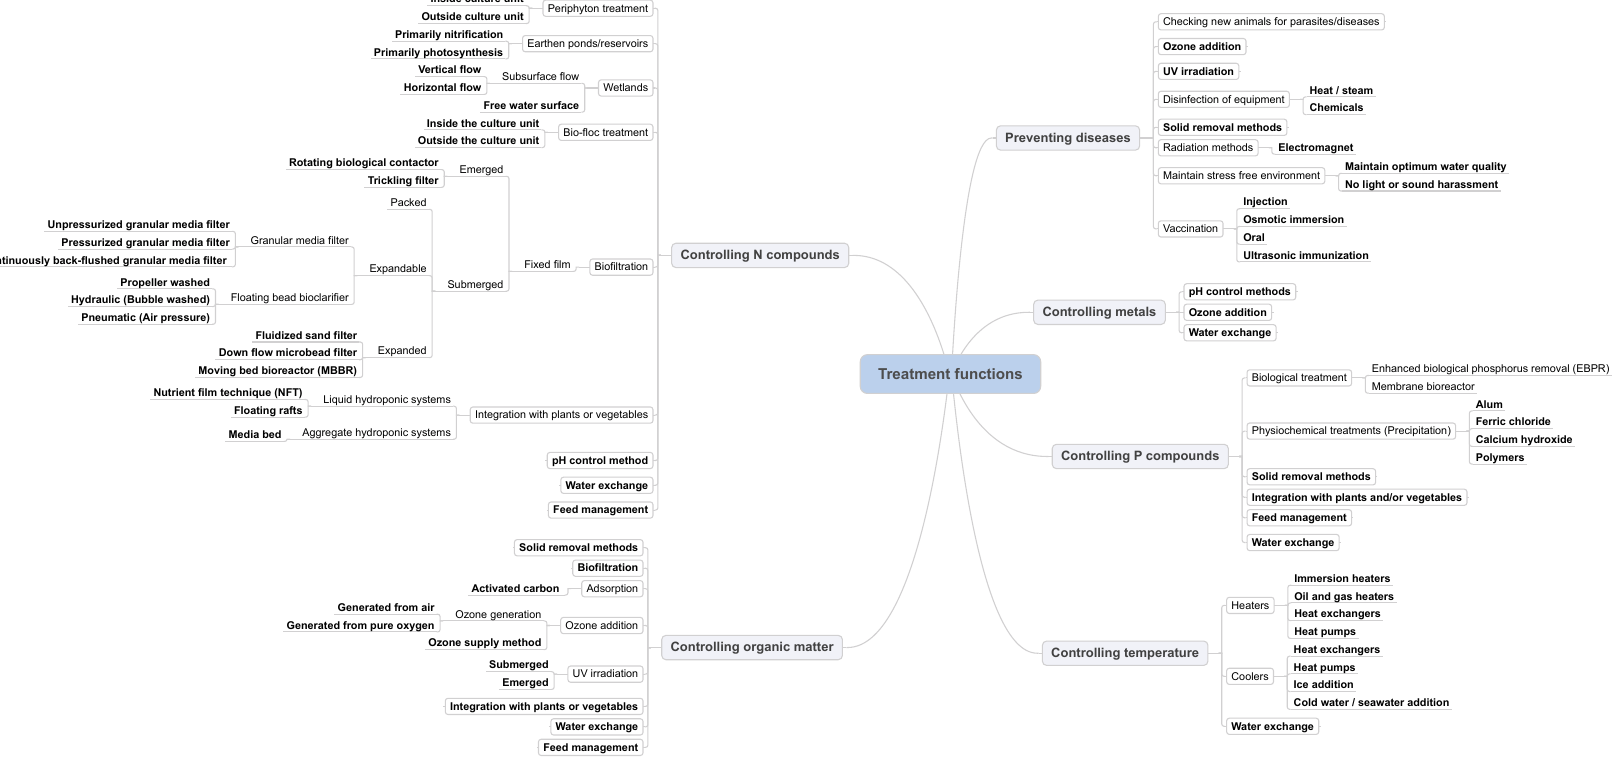
Figure 1. Taxonomy Part